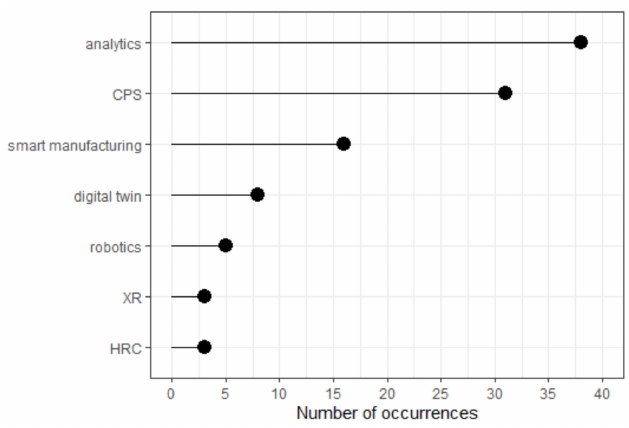
Figure 4. Recurring themes in